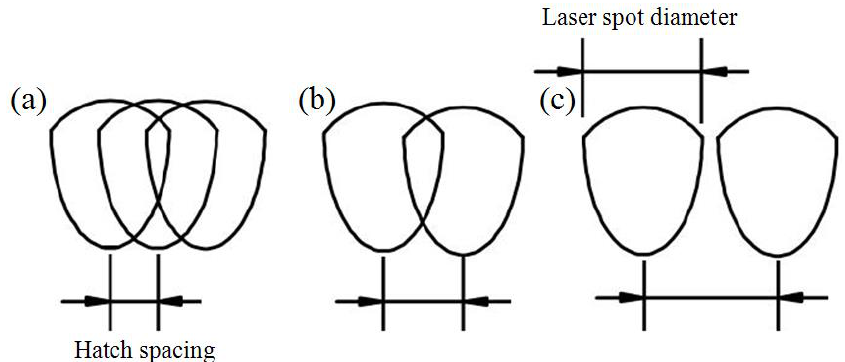
Figure 7. SLM build-up from overlapping of hatch spacing. ( a ) More and multiple overlap, ( b ) normal overlap, ( c ) no overlap.